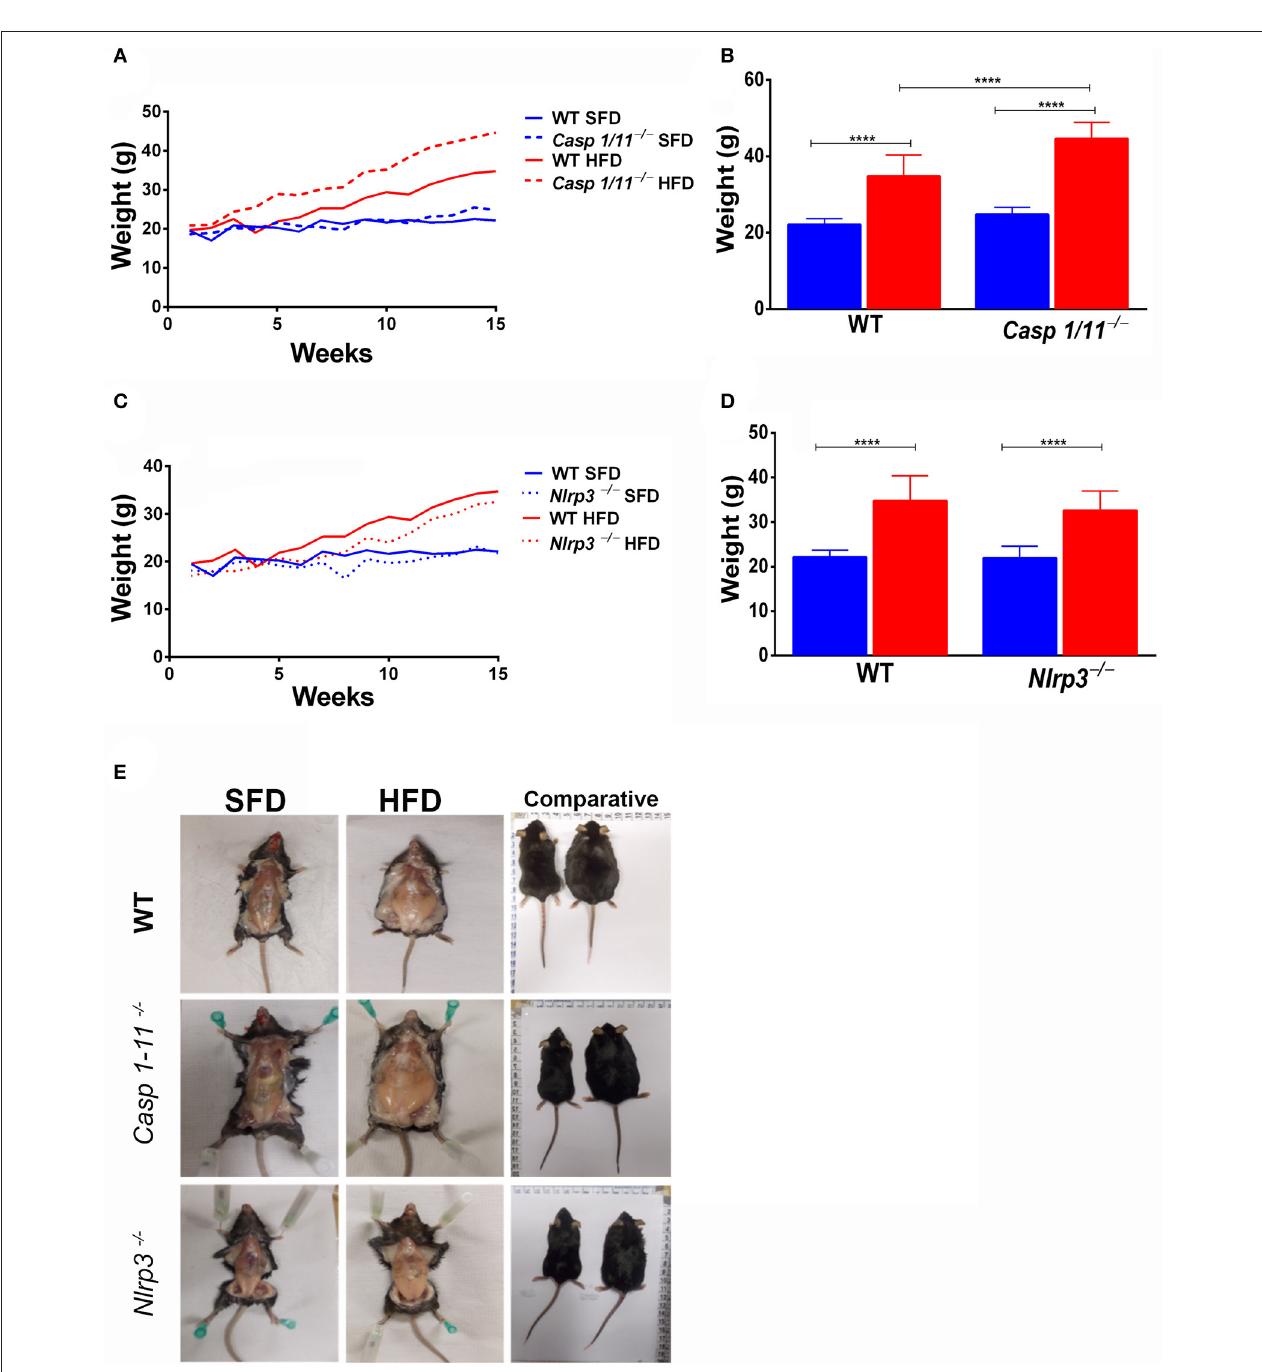
FIGURE 1 | Establishment of high-fat-diet-induced obesity. WT, caspase-1/11 − / − and Nlpr3 − / − mice were fed SFD (17% fat) or HFD (45% fat) for 90 days. The weight gain curve was fitted with the weekly weighing of the animals (A,C) . Weight of the animals at the final of treatment (B,D) and abdominal fat (E) . ANOVA test was applied, the bars representing confidence interval of 95% (**** p < 0.0001).